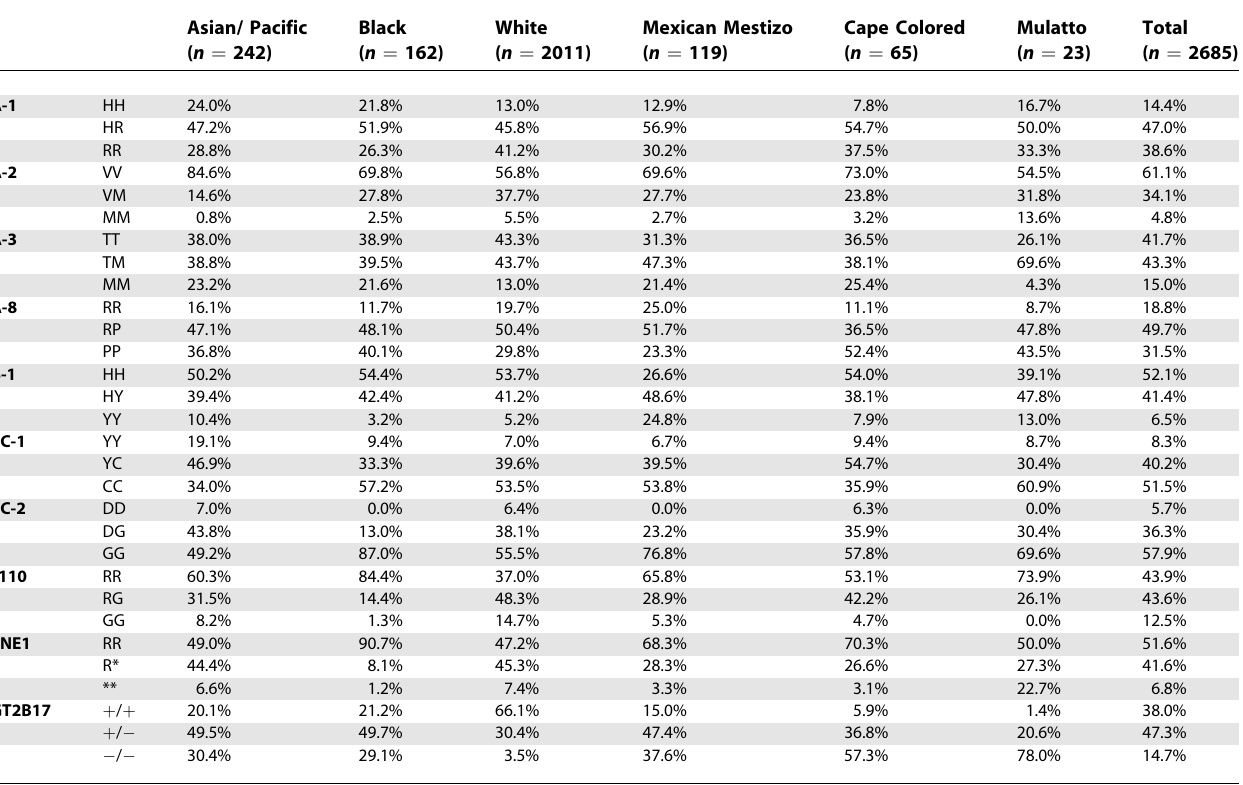
Table 3: Genotype Frequencies of Ten Autosomally Encoded Minor H Antigens in Six Different Ethnic Populations